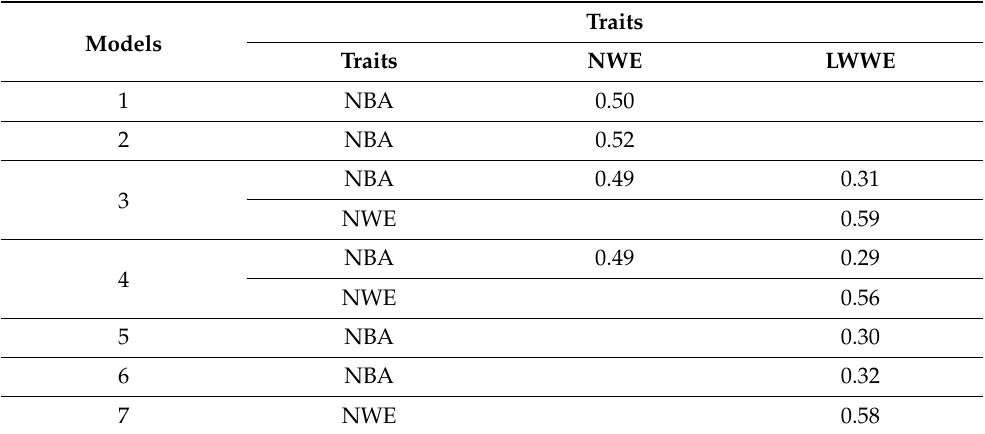
Table 13. Genetic correlations between the pure breed and cross breed performances (Pr > |t| < 0.0001). Models